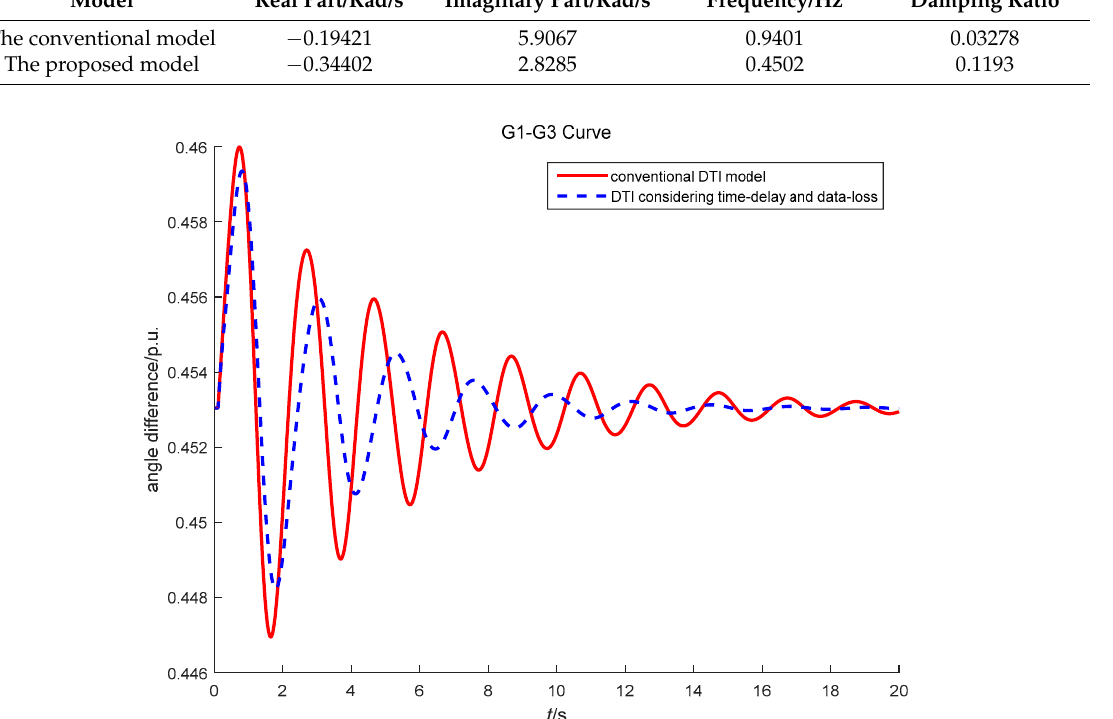
Table 1. Characteristics and DTI results of different feedback signals.